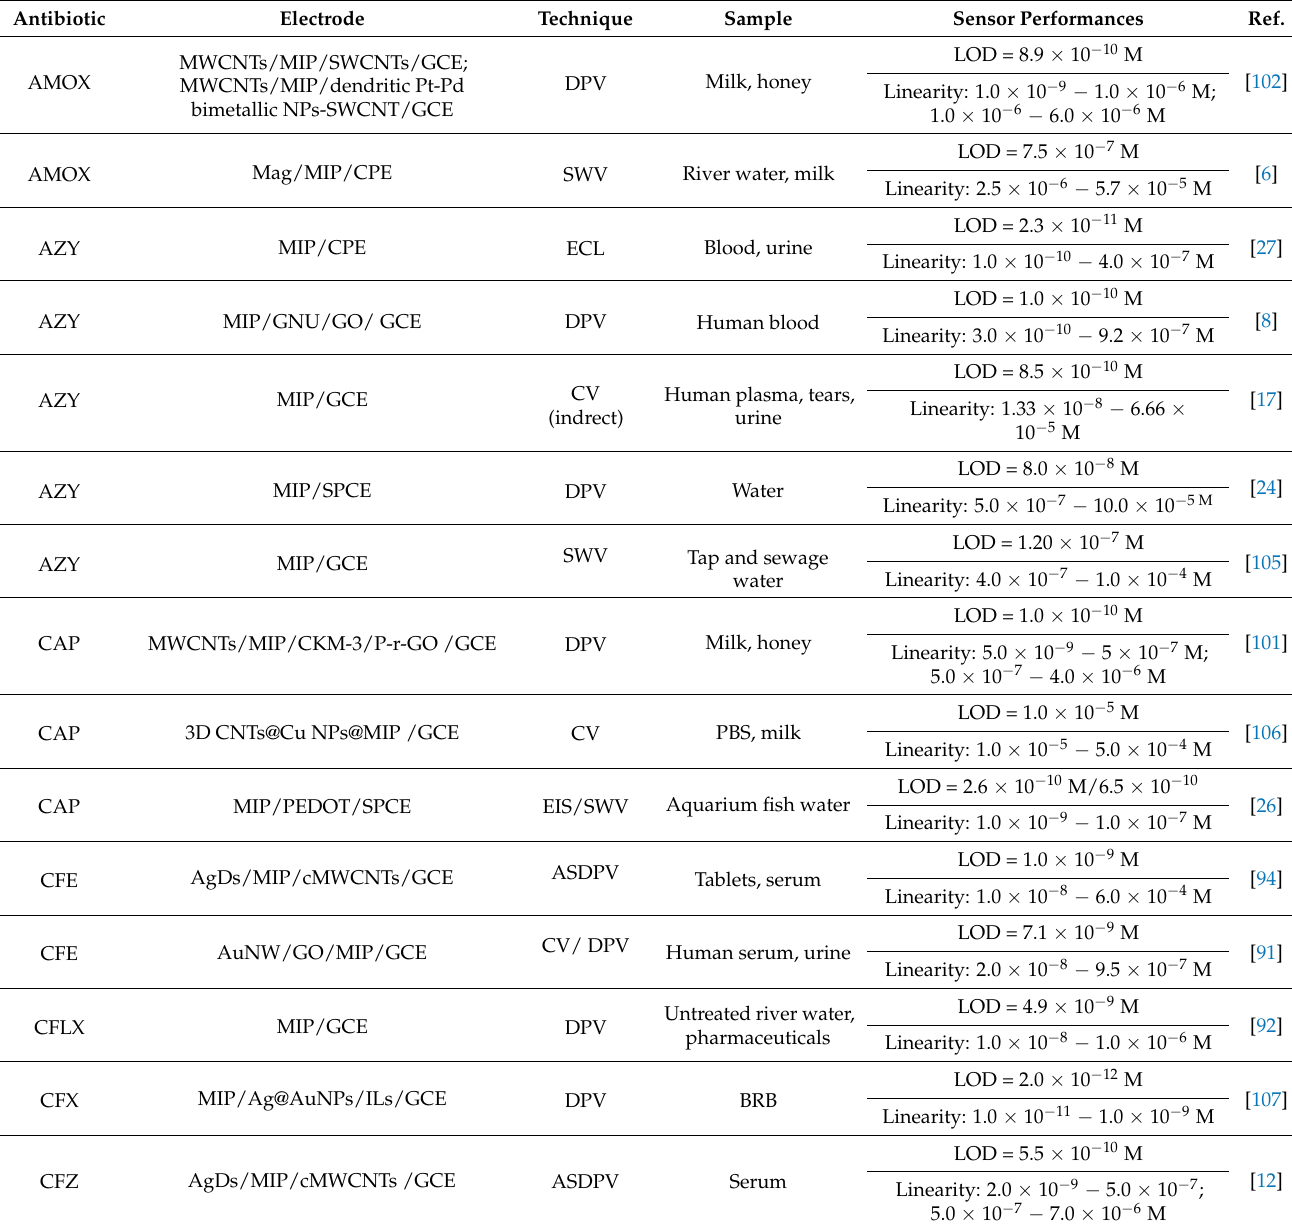
Table 2. Sensor’s performances and sample